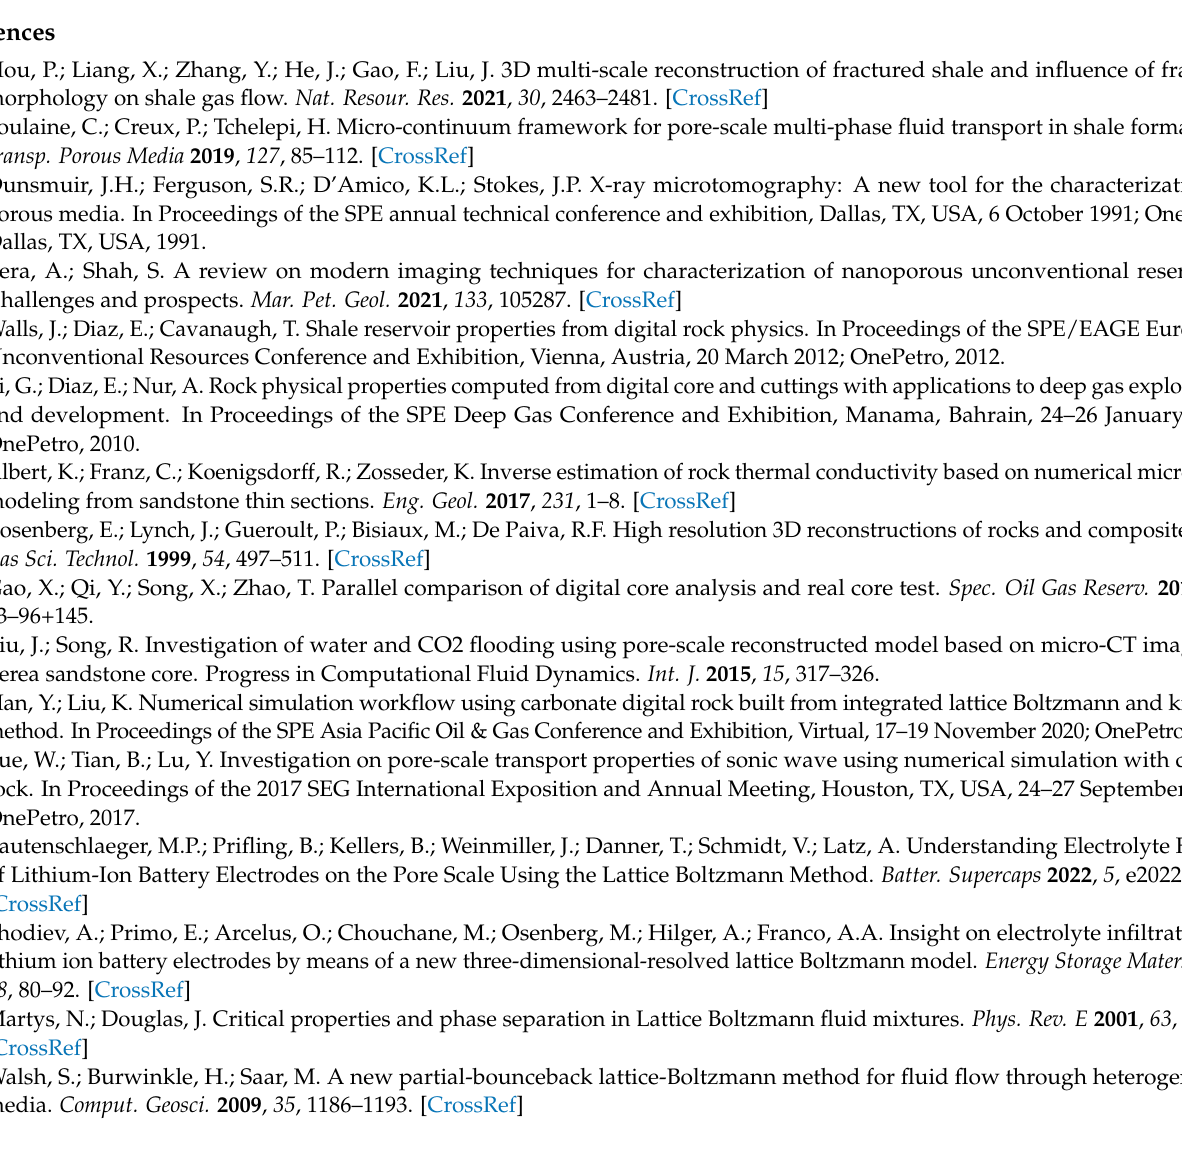
The accuracy of the digital core model constructed by the three modeling methods needs further improvement. Although it can reflect the structural characteristics of the reservoir, the single structure method and mixed numerical reconstruction method still need to be improved to simulate the pore structure and improve the application results